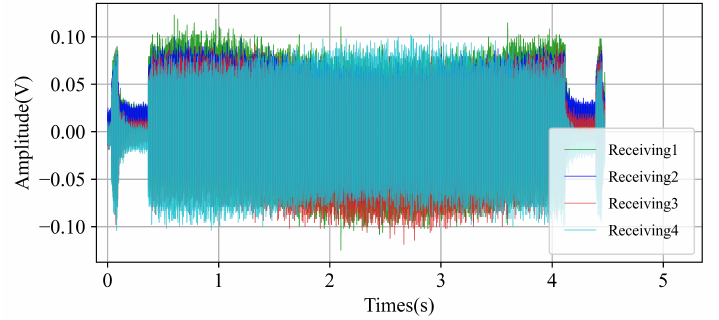
Figure 20. Time-domain visualization of the received signal in the on-lake experiment.